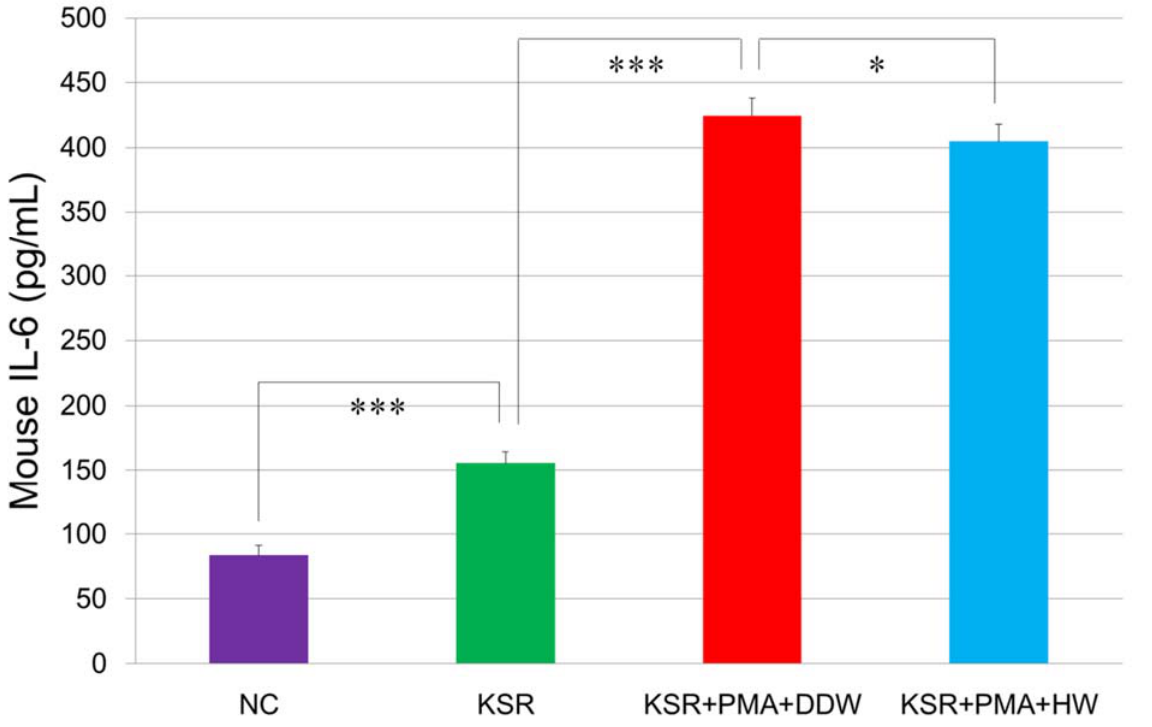
Figure 7. Repressive effects of HW on PMA-increased IL-6 secretion in OP9 adipocytes. OP9 preadipocytes (30,000 cells/well) were seeded into 24-well plates and grew to 100% confluence in the maintenance medium. Cells were then cultivated in DDW- or HW-prepared KSR medium with or without PMA of 10 ng/mL for 4 days. The NC cells were cultivated in the maintenance medium. At the end of cultivation, concentrations of IL-6 in cell culture supernatant were measured by ELISA as described in Materials and Methods. * p < 0.05; *** p < 0.001. Each bar represents the mean ± SD of three independent experiments.